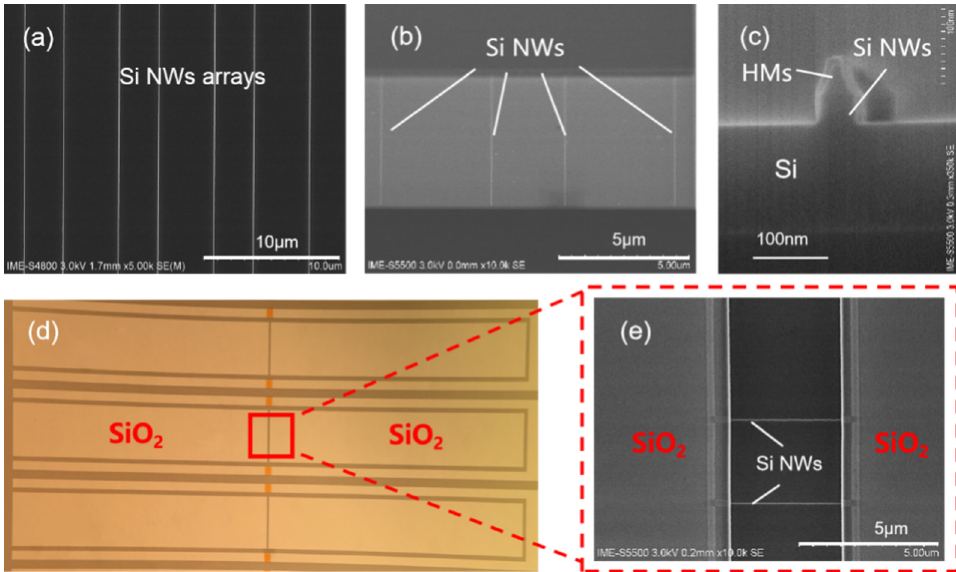
Figure 3. Images of poly-Si NW sensors. ( a , b ) SEM images of poly-Si NW array in top view, ( c ) cross-sectional SEM image of poly-Si NWs, ( d ) top view of poly-Si NW arrays sensor by optical microscope, ( e ) SEM image of the final poly-Si NW arrays sensor in top view.